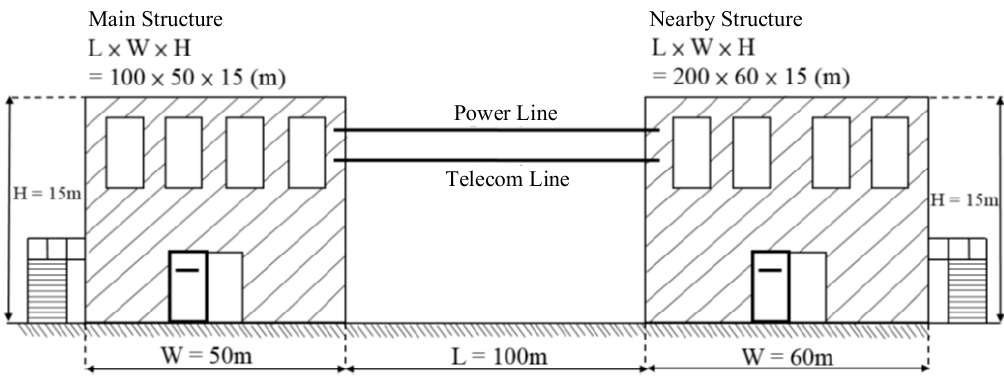
Figure 3. The simulation model.